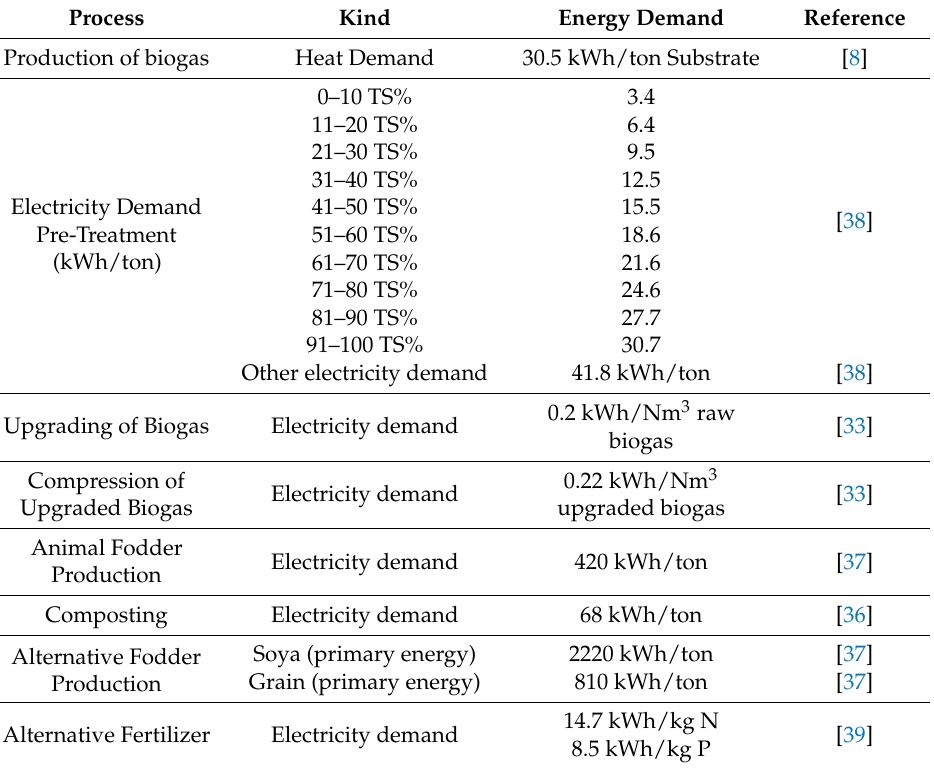
Table A4. Energy demand for different processes included in the study.